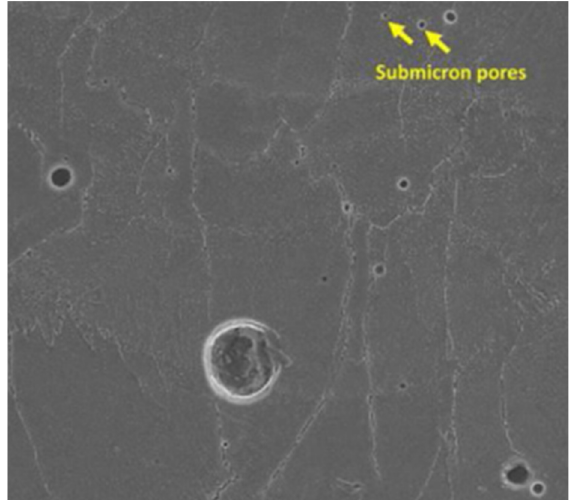
Figure 6 . Illustrative example of gas porosity using SEM [16]. Figure 6. Illustrative example of gas porosity using SEM [16].